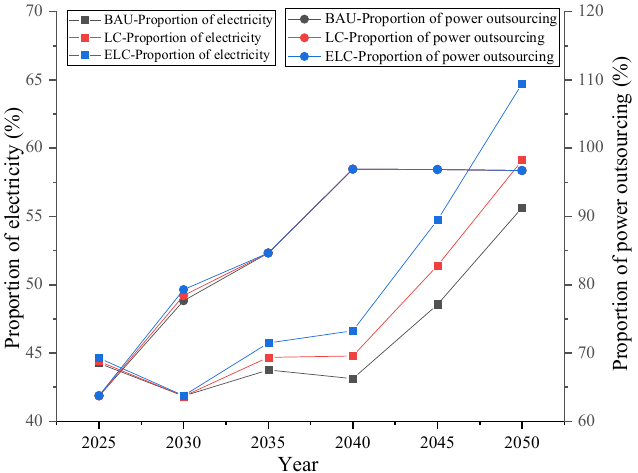
Figure 4. Analysis of the proportion of power consumption in total energy consumption and the proportion of power outsourcing.